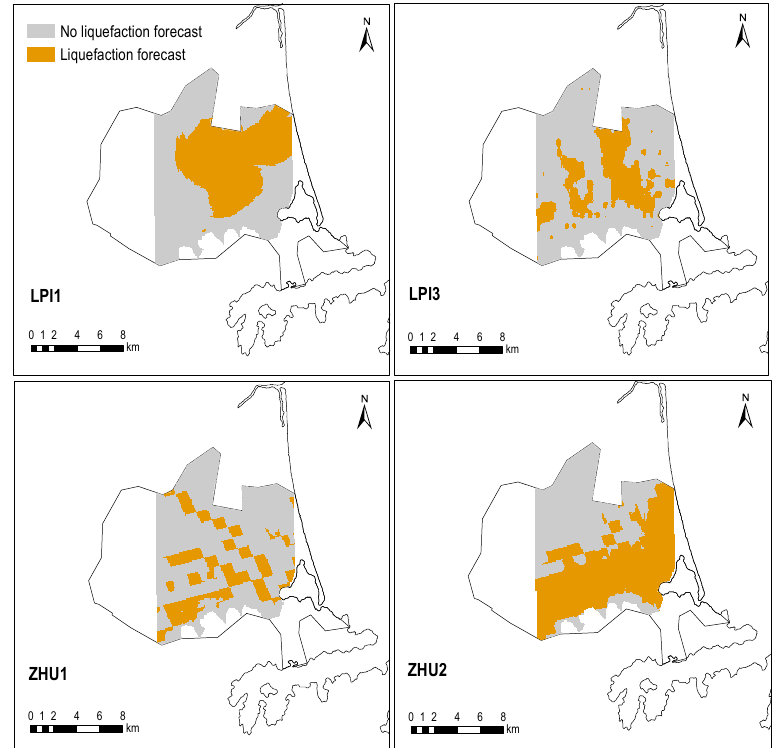
Figure 6. Maps of liquefaction forecasts from selected models for the Darfield earthquake. Unshaded areas are where no forecast was made due to unavailability of input data. Refer to Table 4 for descriptions corresponding to model